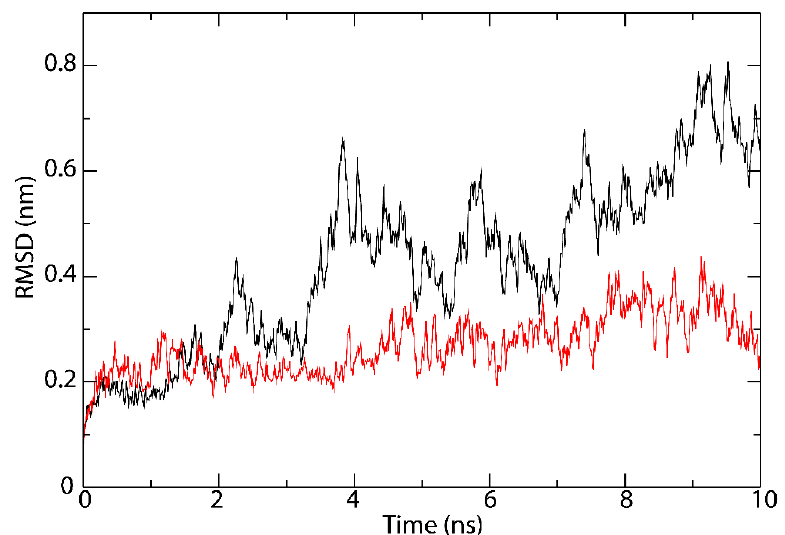
Figure 5. Molecular dynamics (MD) simulation of the peptide/protein complex between YQPYRVVVL and HLA-B*08:01 (black), and the peptide-free protein HLA-B*08:01 (red).